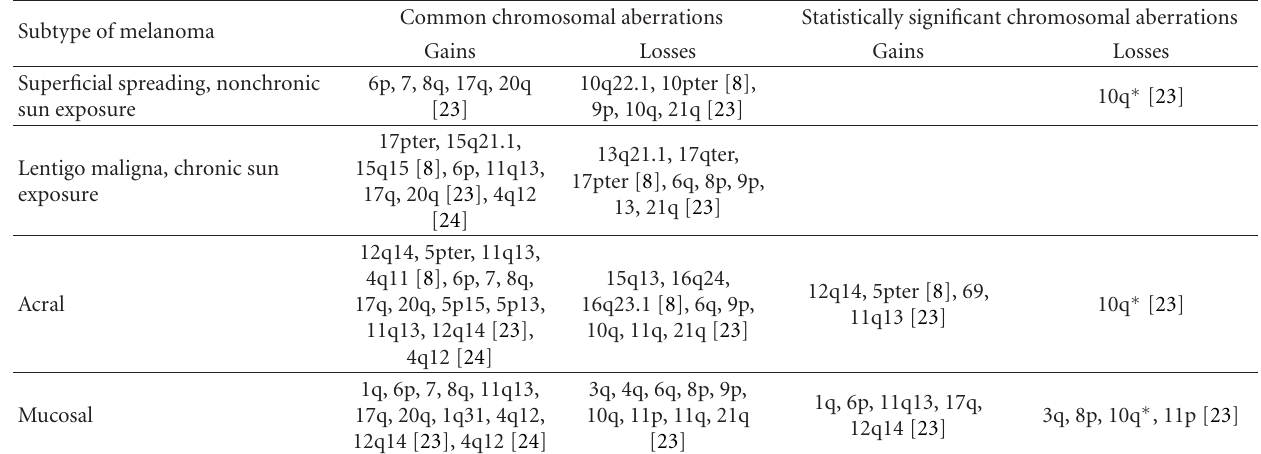
Table 1: Common chromosomal aberrations found in specific melanoma subtypes [8, 23,